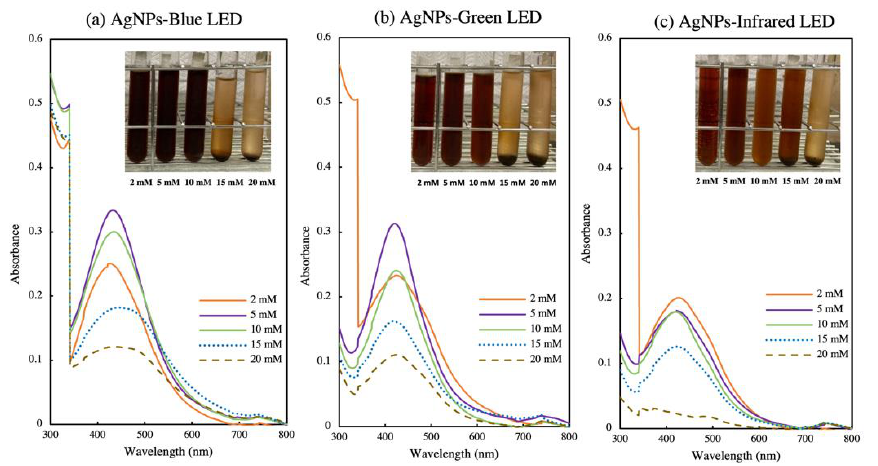
Figure 3. ( a – c ) Optimization of metal salt concentration (2–20 mM) in T. purpurogenus extracellular-pigment-mediated AgNP biosynthesis by blue (AgNPs-blue LED), green (AgNPs-green LED), and infrared (AgNPs-infrared LED) LEDs for 24 h.